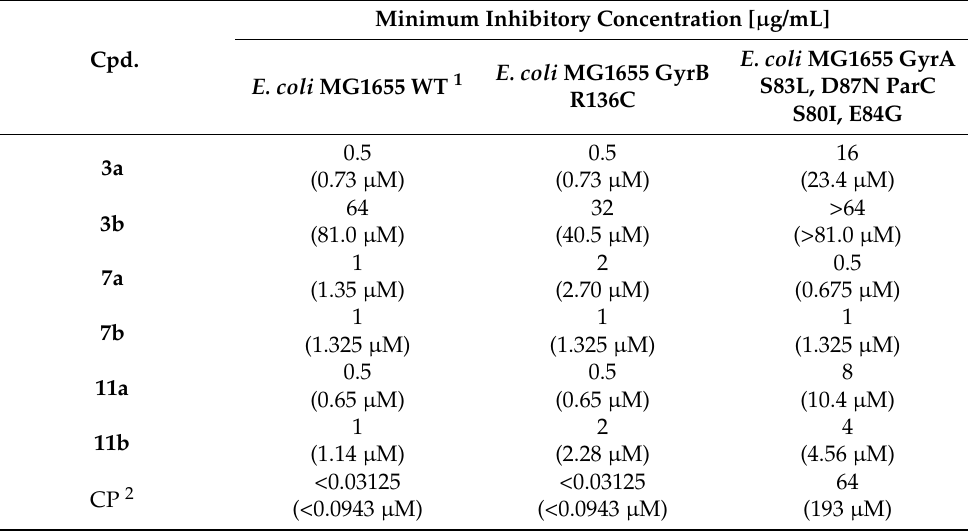
Table 4. Minimum inhibitory concentrations of these new hybrid compounds against the three indicated E. coli MG1655 strains. The assays were carried out in the presence of 50 µ g/mL PA β N.